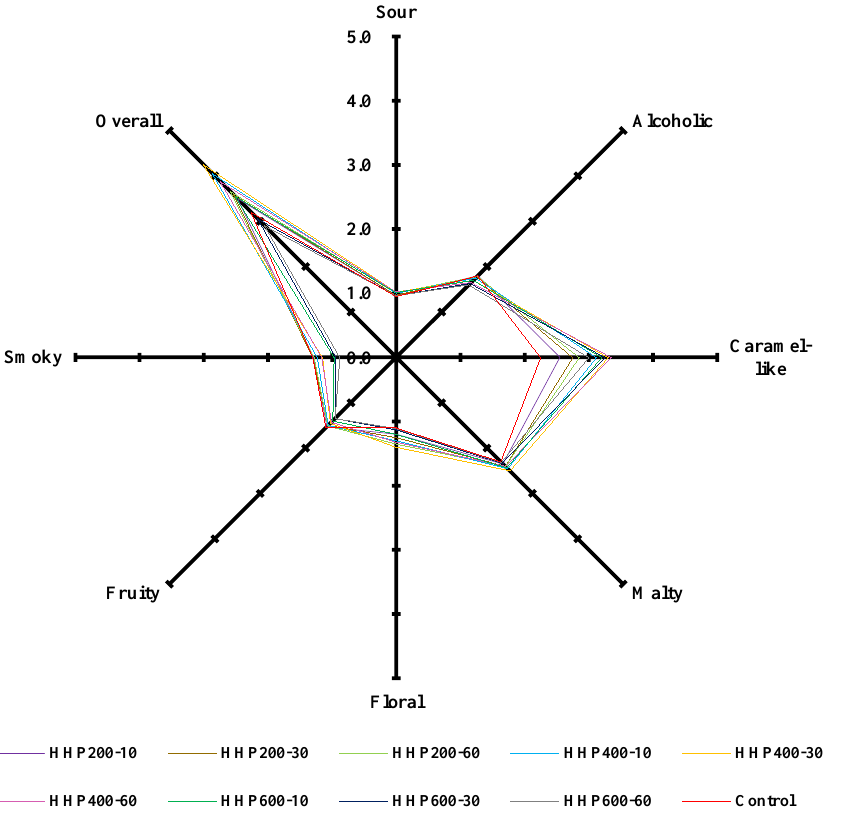
Figure 1. Sensory evaluation of the control and samples.